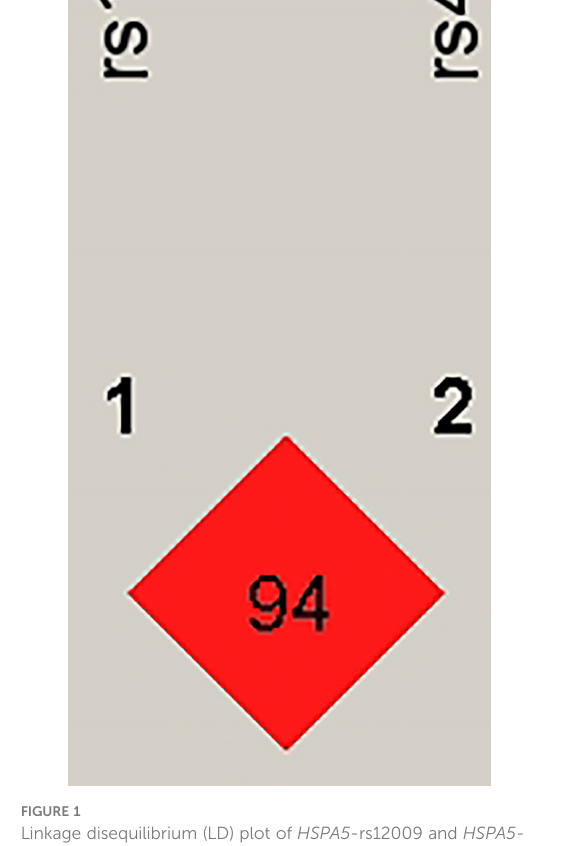
FIGURE 1 Linkage disequilibrium (LD) plot of HSPA5 -rs12009 and HSPA5 - rs430397. The number 98 in the red box represents a strong linkage disequilibrium between HSPA5 -rs12009 and HSPA5 -